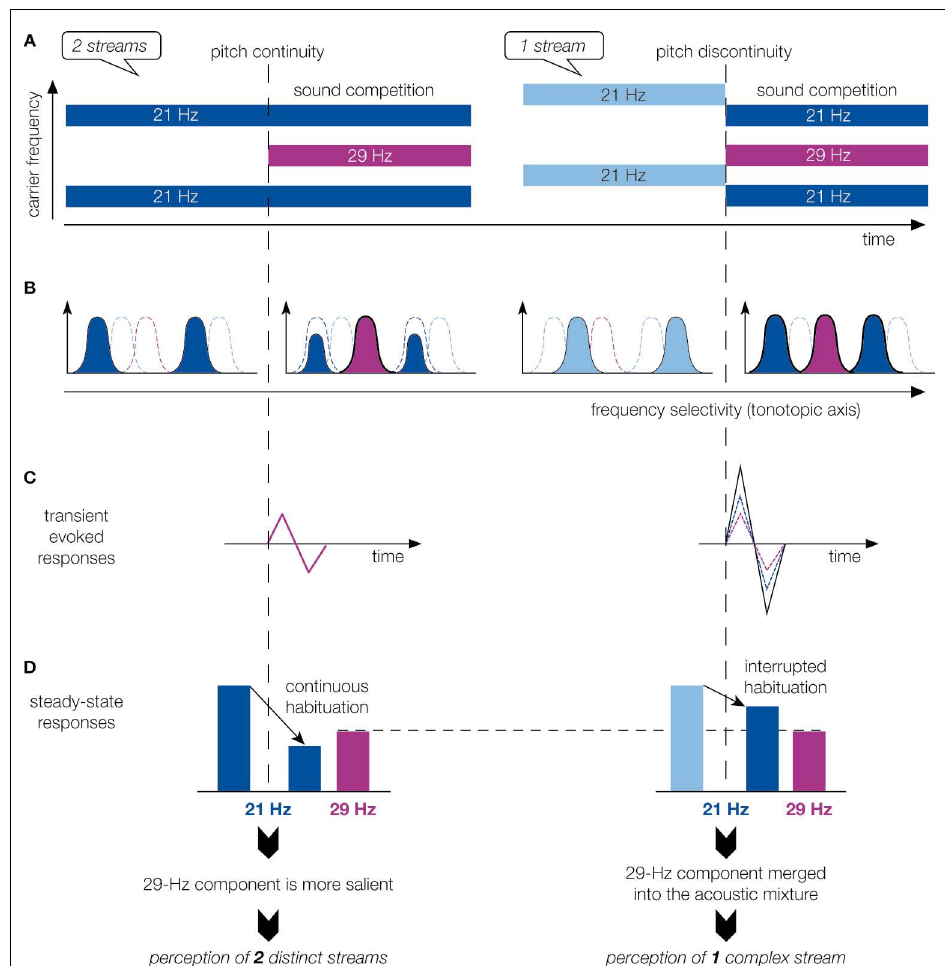
Figure 2 | Schematic representation and interpretation of response modulations recorded from intracortical electrodes in human auditory cortex during concurrent sound perception. (A) Stimuli. During sound competition, stimuli are identically composed of a 21 Hz amplitude-modulated component (blue) and a 29 Hz amplitude-modulated one (purple). When the sound competition period is preceded by the 21-Hz component at the same pitch (pitch continuity), 21-Hz and 29-Hz components are asynchronous and two streams are perceived (left panel). When the sound competition period is preceded by the 21-Hz component at a different pitch (pitch discontinuity), 21-Hz and 29-Hz components are synchronous and one stream is heard (right panel). (B) Schematic representation of the neural population activated by the stimuli in a tonotopically organized auditory area before and during sound competition. Bell-shape curves represent spatial activity patterns, along a tonotopic axis, evoked by the acoustic component represented in A with the same color. Bold curves indicate groups of neurons activated only during sound competition. Dashed curves indicate groups of neurons not activated during the considered period. (C) Schematic representation of the transient responses evoked at the onset of sound competition. In the case of pitch continuity (left panel), only responses to the 29-Hz component onset (purple) are observed. In the case of pitch discontinuity (right panel), responses to both the 29-Hz component onset (dashed purple) and the 21-Hz component pitch discontinuity (dashed blue) contribute to the larger recorded responses (black). (D) Schematic representation of the amplitude of steady-state response (SSR) at 21 and 29 Hz. 29-Hz SSR (purple) is observed only during sound competition with similar amplitudes in both conditions. 21-Hz SSR (blue) is observed during the whole stimulus duration, its amplitude is decreasing with time, probably because of habituation mechanisms. In the case of pitch continuity, habituation mechanisms are not interrupted, resulting in a 21-Hz SSR of small amplitude during sound competition. When habituation mechanisms are interrupted by the pitch discontinuity, the 21-Hz SSR is of larger amplitude during sound competition. Thus, frequency-selective habituation mechanisms modulate amplitude ratios between 29 and 21 Hz SSR. In the case of pitch continuity, the 21-Hz SSR being highly reduced, the 29-Hz response becomes relatively more important, resulting in an increased saliency of the new-coming 29-Hz component. Conversely, in the case of pitch discontinuity, the 21-Hz response being slightly reduced, the 29-Hz component tends to merge into the acoustic mixture and the two components are grouped into one complex stream. Importantly, this result interpretation is valid if the responses are generated in auditory areas with frequency-selective neurons, but not necessarily tonopically